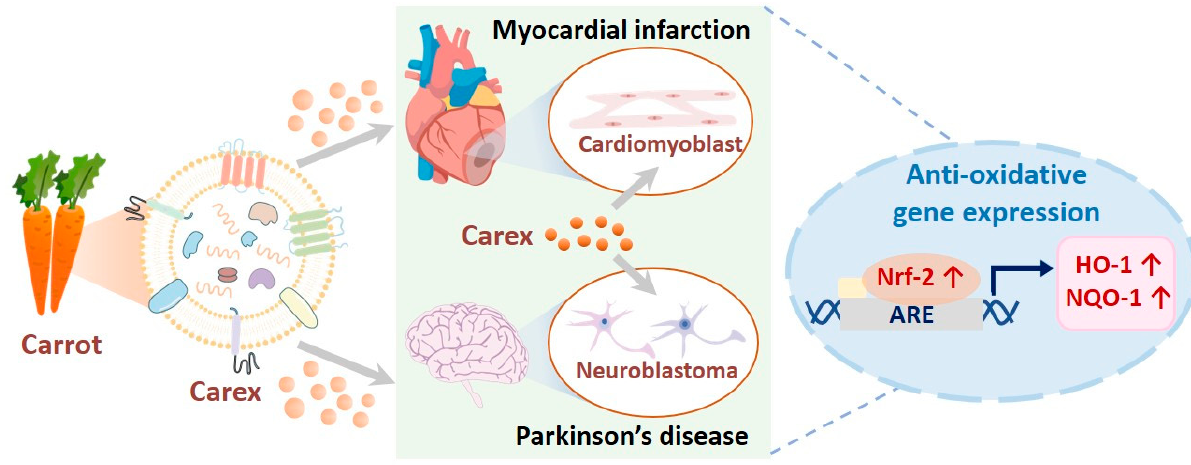
Figure 1. Illustration of carrot-derived nanovesicle (Carex) isolation from carrots and the investigation of the antioxidative effects and molecular regulations in cardiomyoblast and neuroblastoma cells as in vitro model systems for myocardial infarction and Parkinson’s disease, respectively.